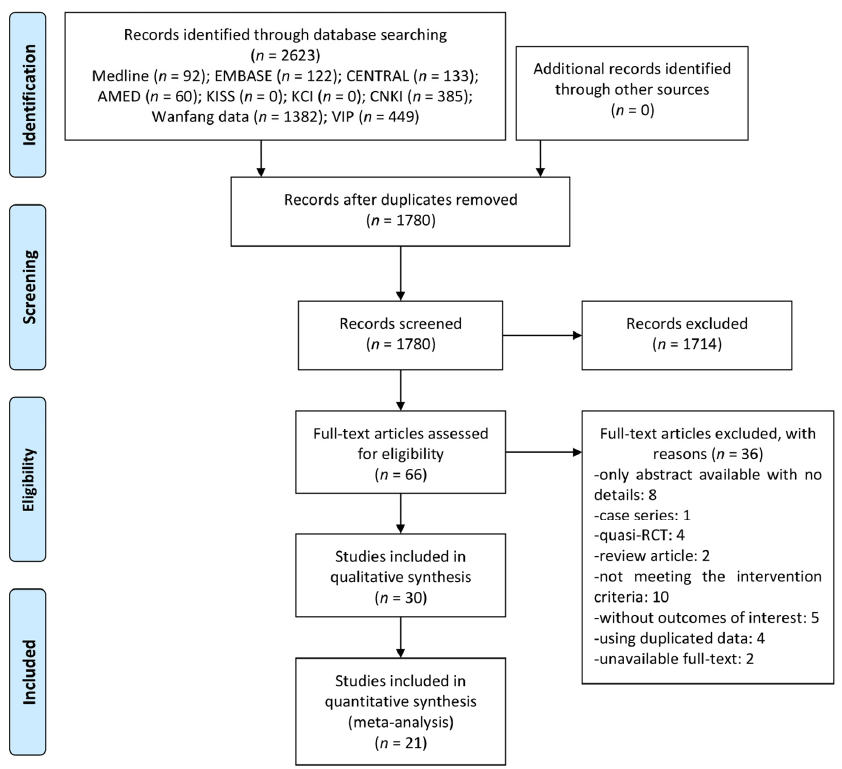
Figure 1. A PRISMA flow diagram of the literature screening and selection process. AMED—Allied and Complementary Medicine Database; CENTRAL—Cochrane Central Register of Controlled Trials; CNKI—China National Knowledge Infrastructure; KCI—Korea Citation Index; KISS—Korean